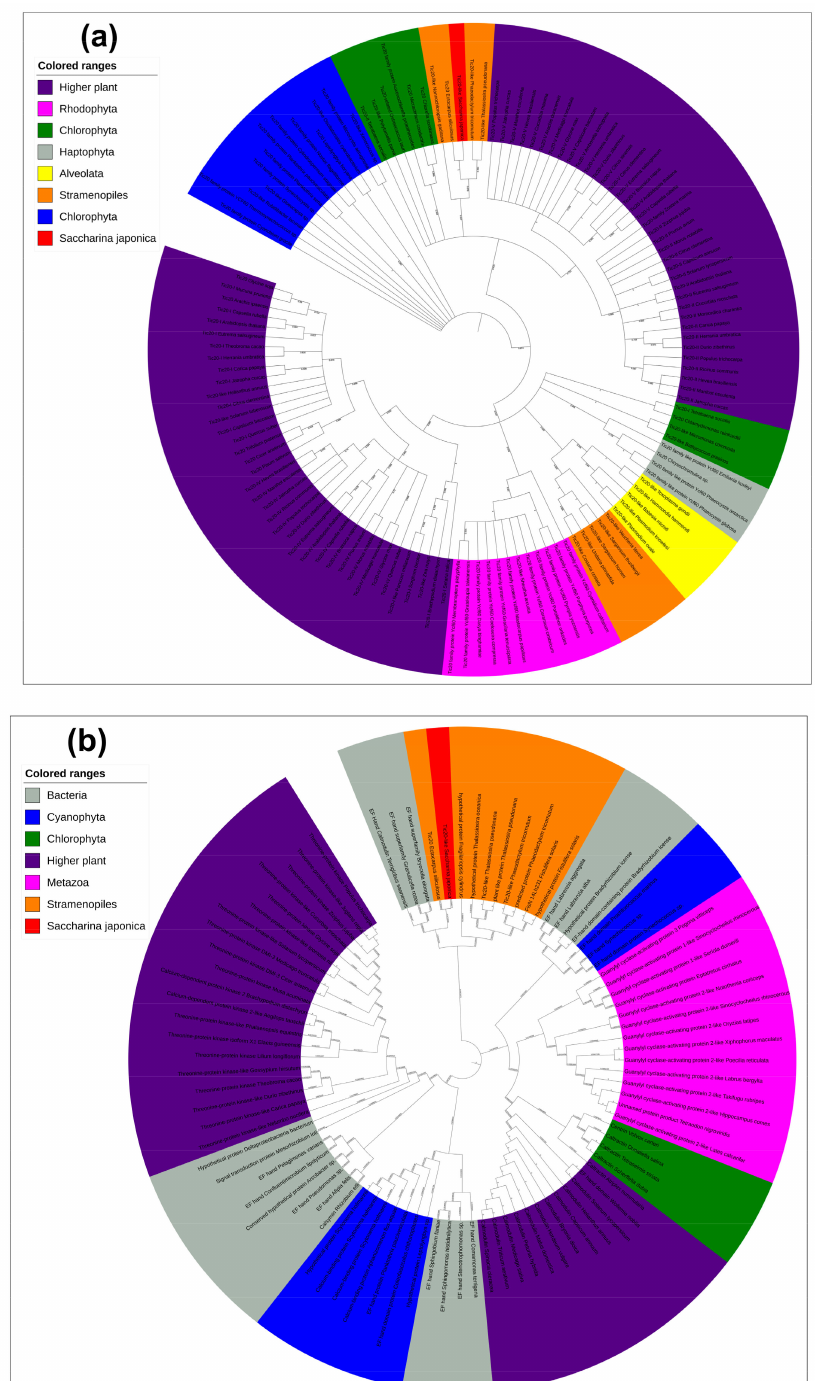
Figure 3. Phylogenetics of subsets of Tic20-like amino acids and EF-hand domains. ( a ) Phylogenetic analysis of Tic20-like proteins. Proteins from higher plants are shown in violet, Cyanophyta in blue, Chlorophyta in green, Rhodophyta in pink, Haptophyta in grey, Alveolata in yellow, Stramenopiles in orange, and S. japonica in red. ( b ) Phylogenetic analysis of EF-hand domain proteins. Proteins from bacteria are shown in grey, higher plants in violet, Metazoa in pink, Cyanophyta in blue, Chlorophyta in green, Stramenopiles in orange, and S. japonica in red. Protein item accession numbers are shown in Tables S2 and